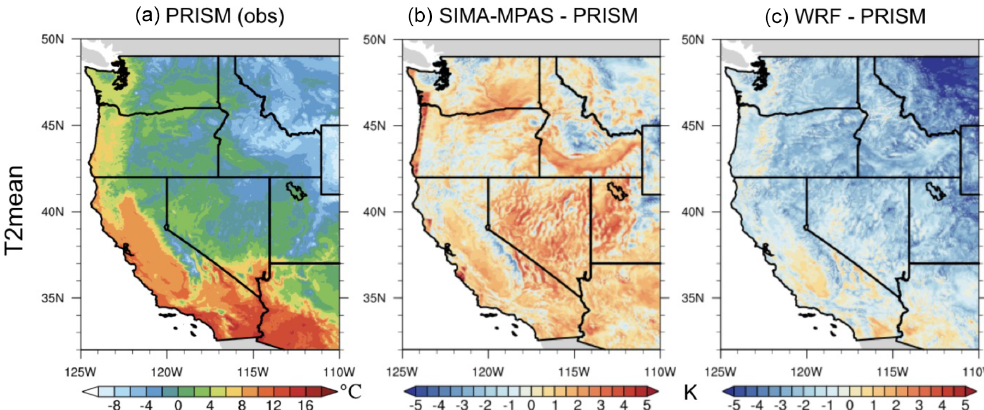
Figure 8. Daily mean 2m air temperature (T2mean) averaged over 1999–2004, November–March. (a) PRISM observation dataset; (b, c) the differences between SIMA-MPAS and PRISM and between WRF and PRISM respectively (note for the difference plots, all data are regridded to the same resolution as